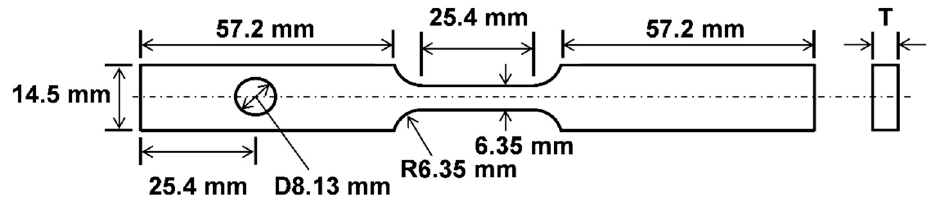
Figure 1. Schematic of tensile specimen geometry.